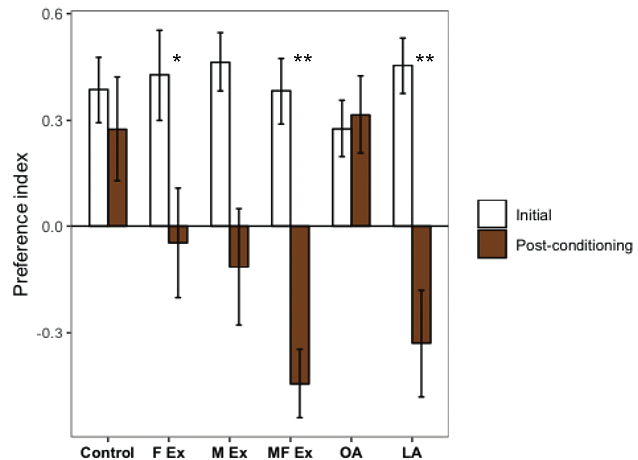
Fig. 1. Changes in olfactory preference index for adult crickets (